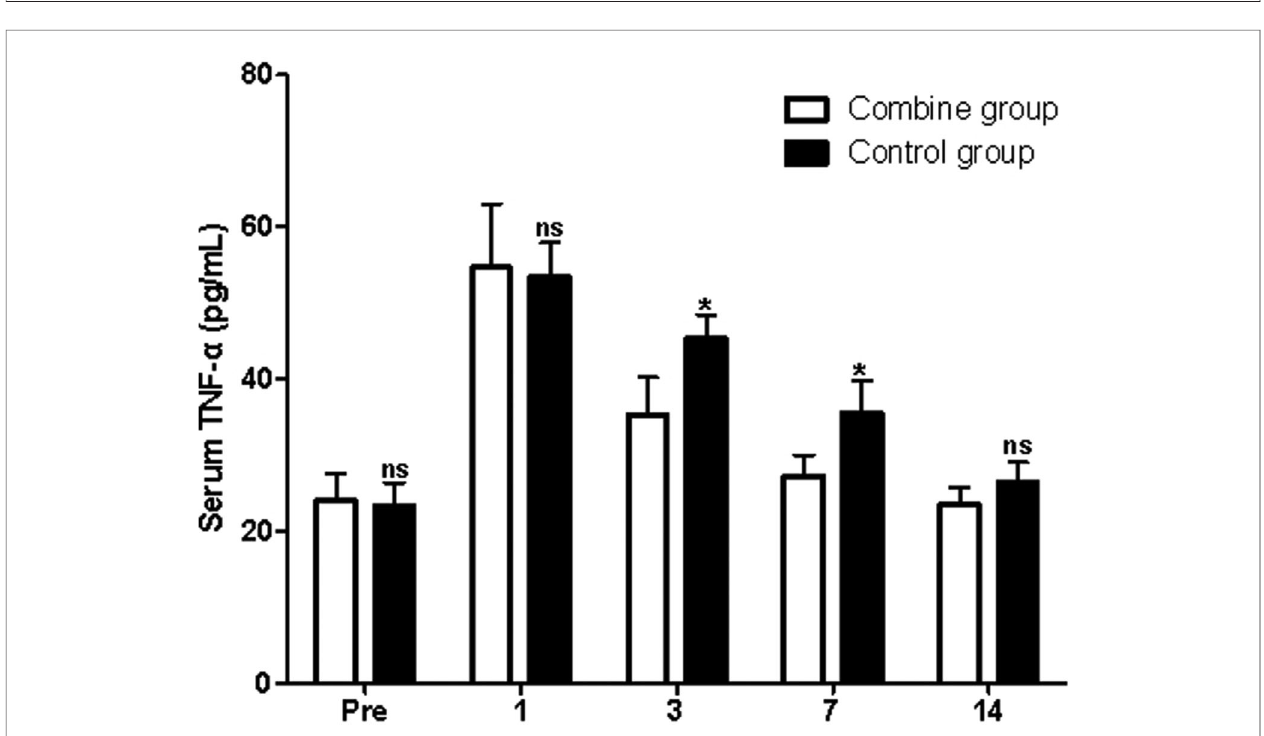
FIGURE 5 | Comparison of serum TNF- α levels at different times in patients of two groups. Note: Compared with the combine group, ns p >0.05 and * p